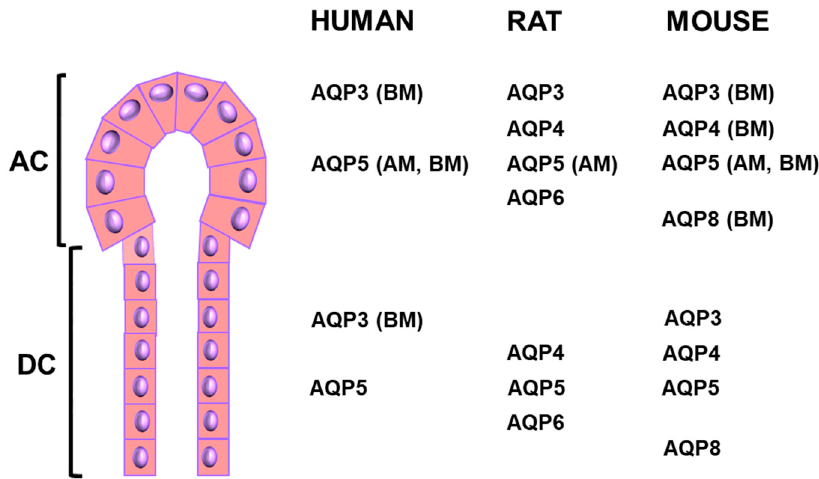
Figure 2. Localization of AQPs in salivary gland acinar and ductal cells. AC: acinar cells; AM: apical membrane; BM: basolateral membrane; DC: ductal cells.